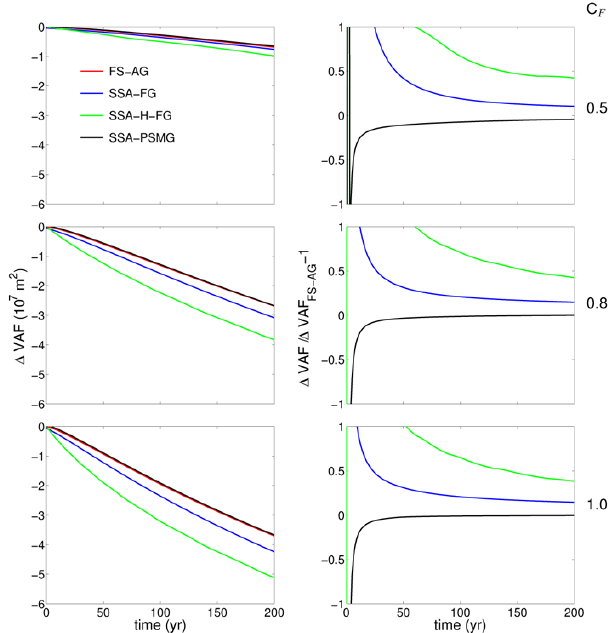
Fig. 6. Temporal evolution of the variation of Volume above Flota- tion ( 1 VAF) for each model (left) and, expressed relative to FS–AG ( 1 VAF FS-AG ) for the three remaining models (right), for the three butressing values